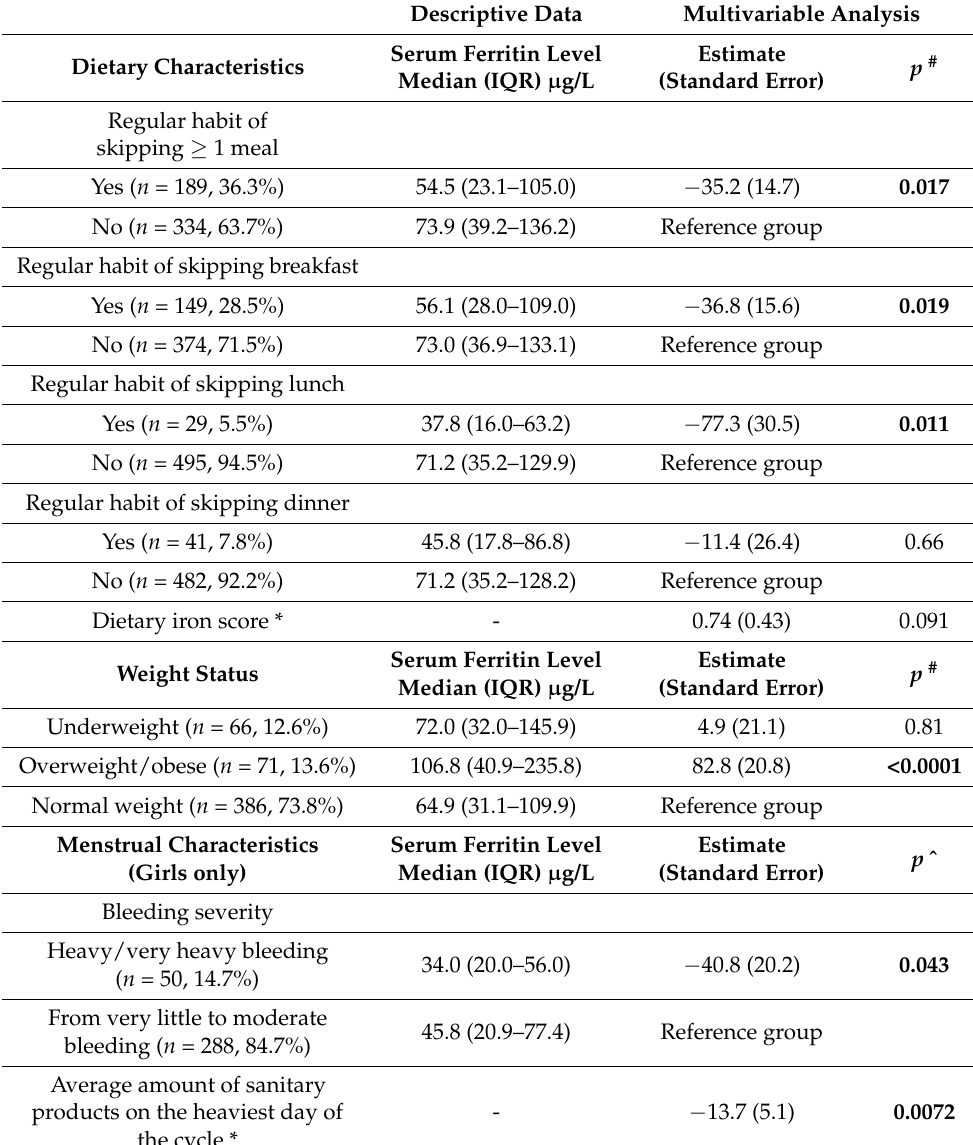
Table 3. Association of serum ferritin with dietary characteristics and menstrual